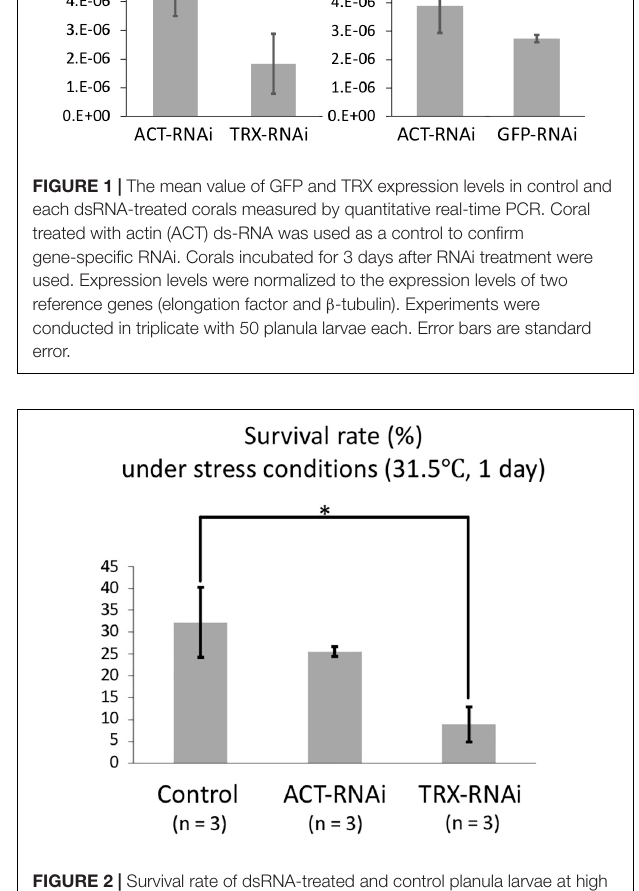
FIGURE 2 | Survival rate of dsRNA-treated and control planula larvae at high temperature (31.5 ◦ C, 1 day). Three replicaties were prepared for each treatment (control, ACT-RNAi, and TRX-RNAi). Each replicate contains 30 larvae, and survival rates were calculated based on the numbers of individuals at the beginning and end of the experiment. The average and standard error of three replicates are shown. Error bars are standard error. Asterisk indicates a significant difference ( p <